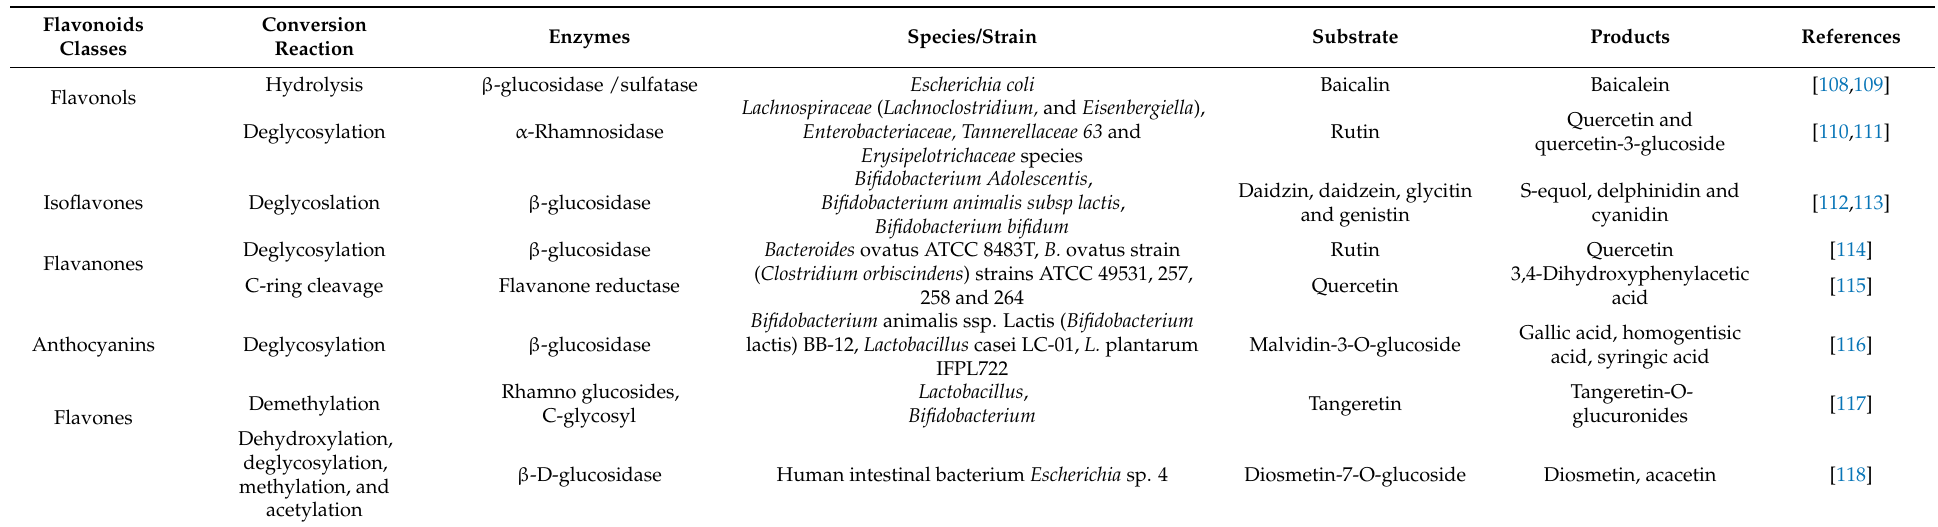
Table 3. The conversion reactions of flavonoids by gut